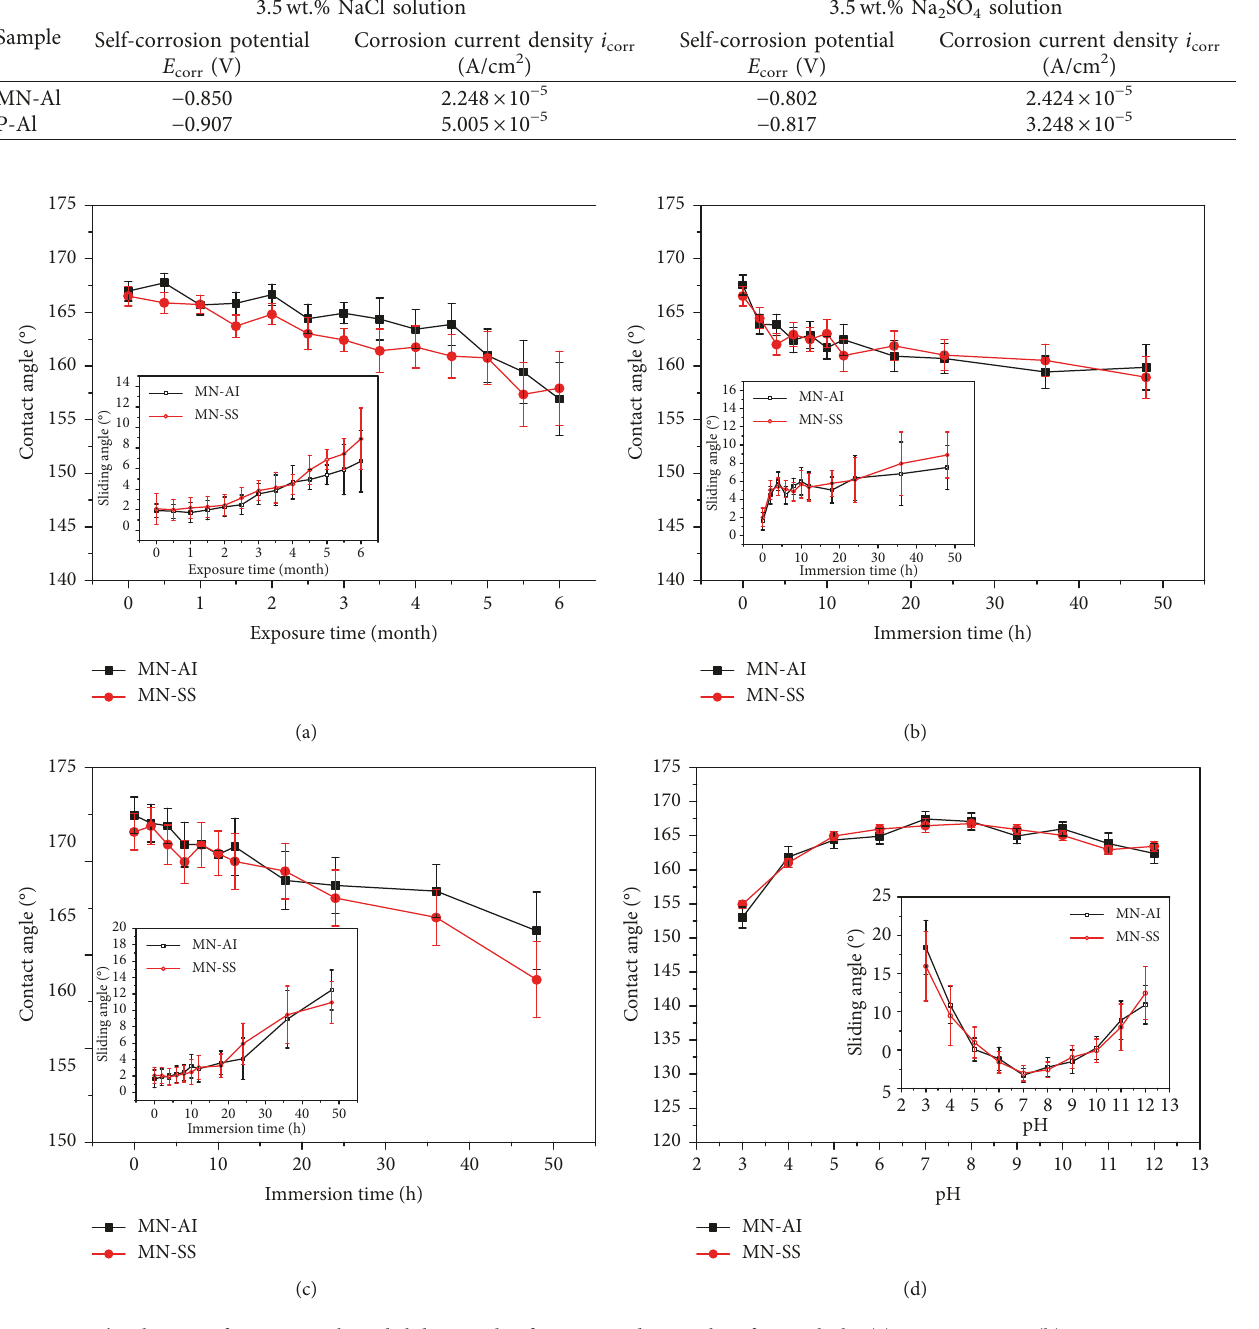
Figure 13: The changes of contact angle and sliding angle of MN-SS and MN-Al surface with the (a) exposure time, (b) immersion time in oil, (c) immersion time in brine, and (d) pH